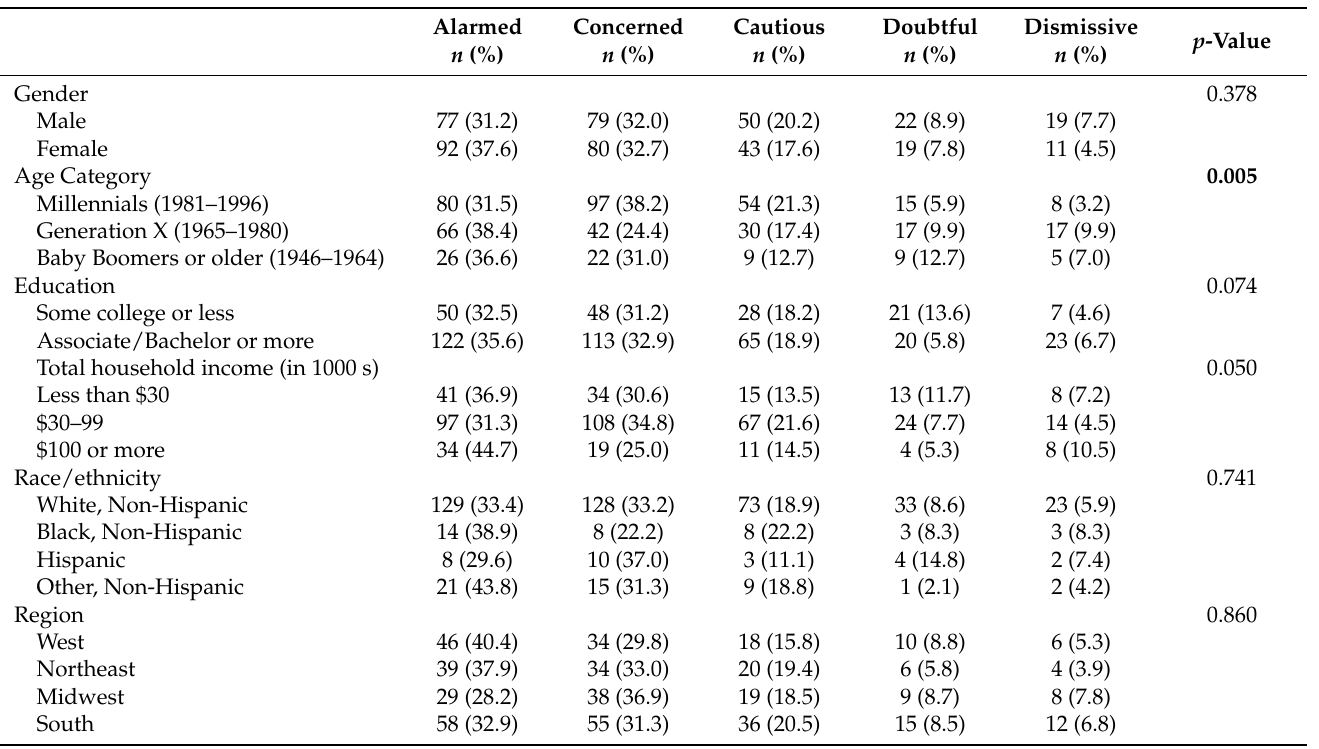
Table 2. Demographic similarities and differences across SASSY Segment in the MTurk sample, n =